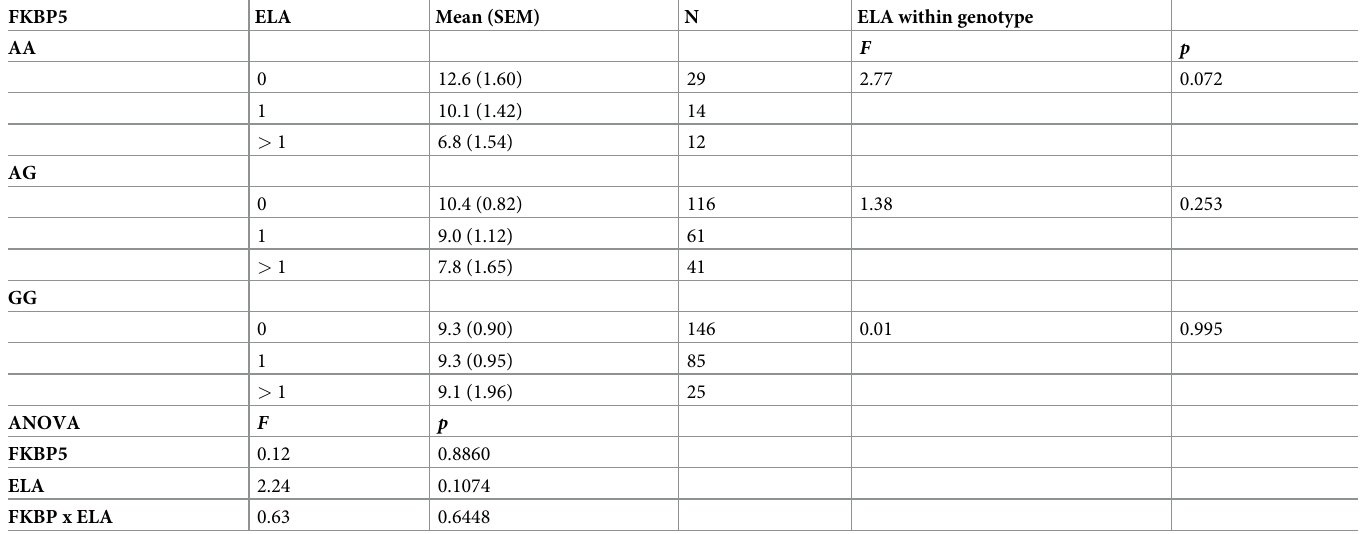
Table 2. Heart rate